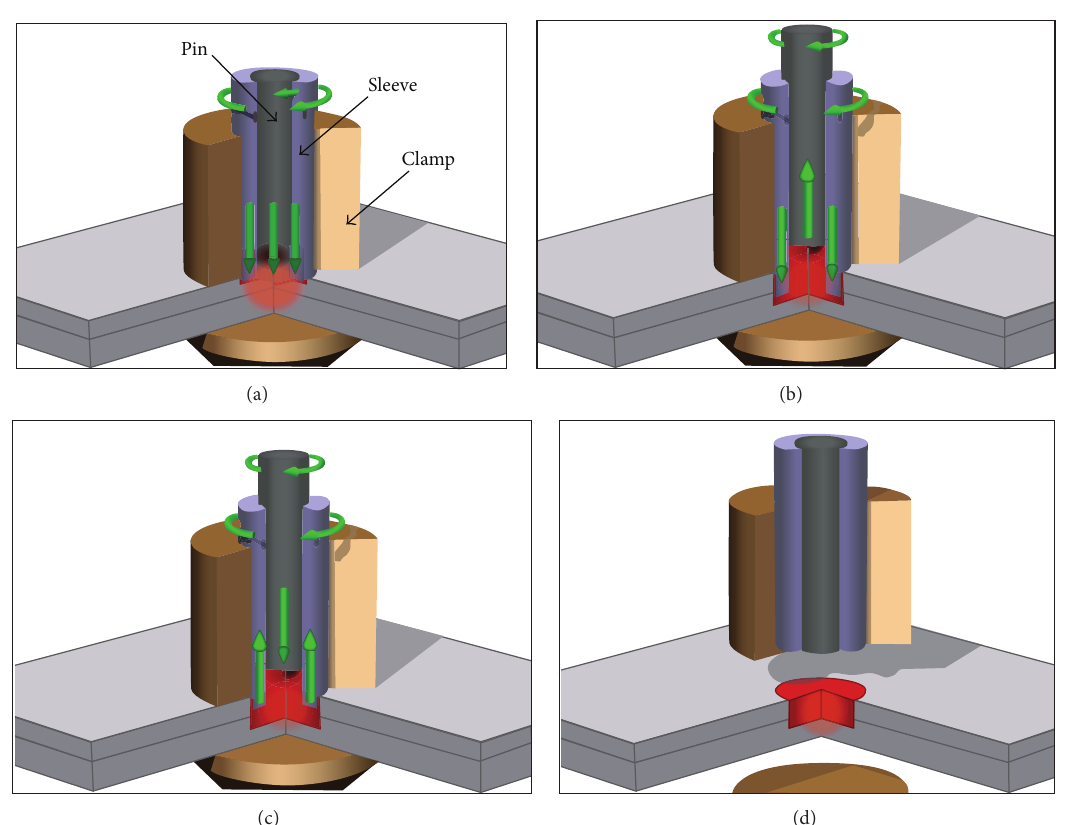
Figure 2: Schematic diagram of the refill FSSW process: (a) friction, (b) first extrusion, (c) second extrusion, and (d) pull-out stage